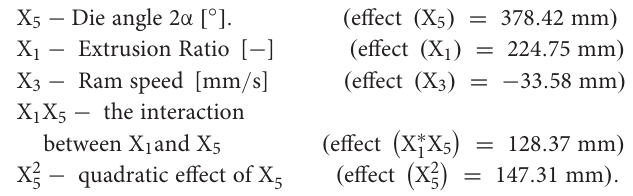
out by means of digital image processing and analysis. For